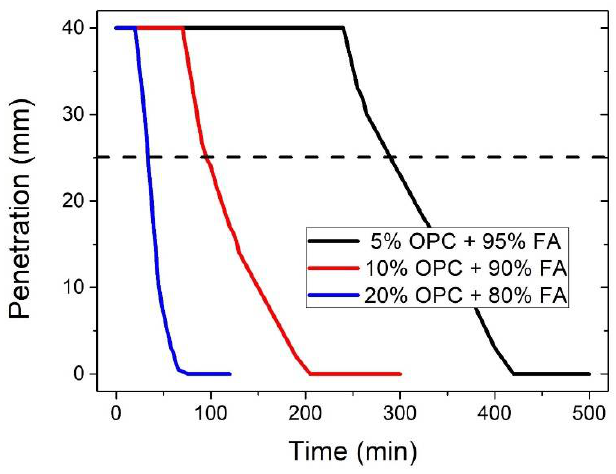
Figure 7. Binder (paste) setting times (initial and final) (ASTM C191). Table 4. Initial and final setting times of the